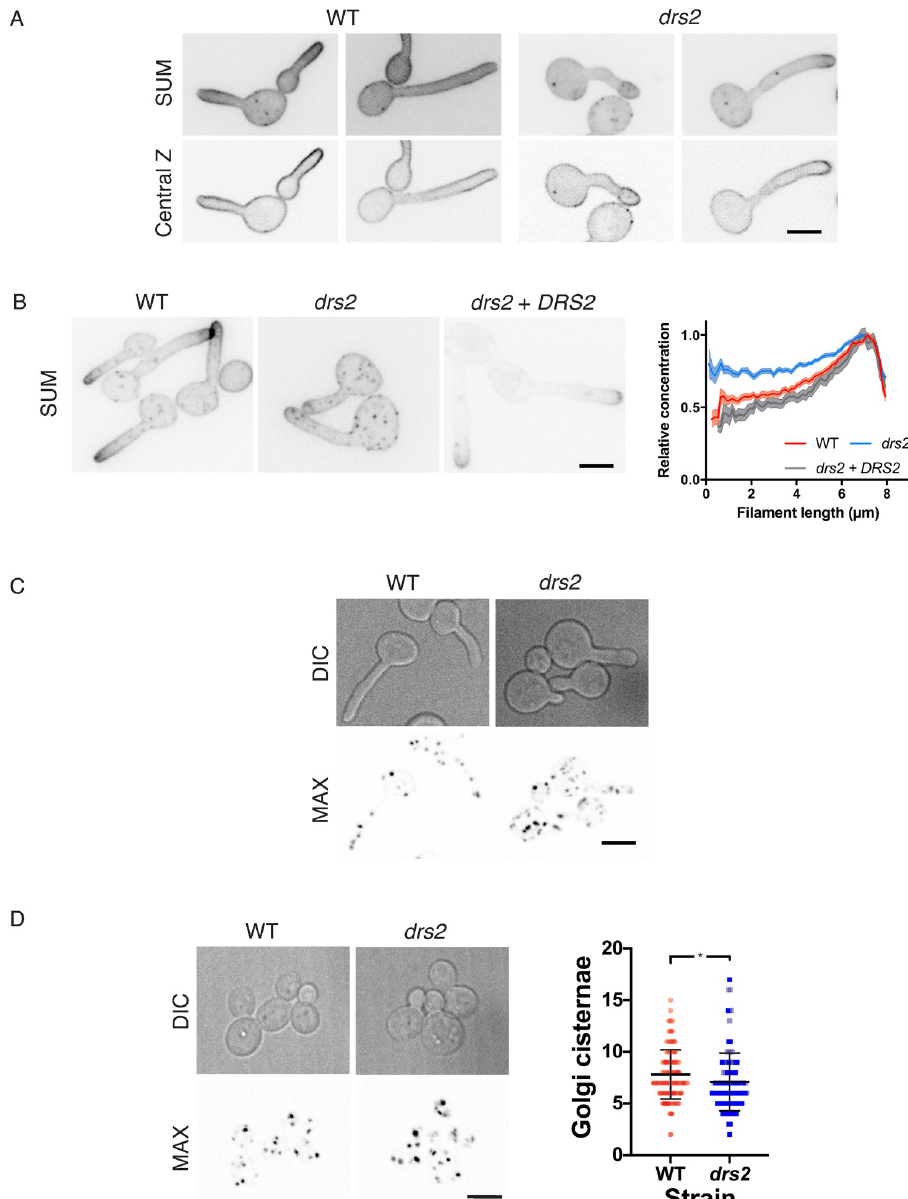
Fig 6. Plasma membrane PI(4)P distribution is altered in the drs2 mutant. A) PM PI(4,5)P 2 distribution is not altered in the drs2 mutant. Wild-type (PY1206) and drs2/drs2 cells ( drs2 , PY4050) expressing GFP-(PH PLC δ 1 ) 2 -GFP were incubated for 60 or 90 min, respectively, in the presence of serum. Sum projections (21 z-sections) and central z- sections of representative cells are shown. B) PM PI(4)P distribution is altered in the drs2 mutant. The indicated cells, WT (PY5619), drs2/drs2 ( drs2 , PY5568) and drs2/drs2 + pDRS2DRS2 ( drs2 + DRS2 , PY6407) expressing GFP-(PH OSH2 [H340R] ) 2 -GFP were incubated for 90 min in the presence of FCS. Sum projections of (21 z-sections) of representative cells are shown. The graph illustrates the means ± the SEM of the relative concentration of PM PI(4)P as a function of filament length, normalized to the maximal signal for each cell ( n = 25–60 cells). C) and D) The number of Golgi cisternae is not substantially affected in the drs2 mutant. DIC and maximum projections (21 deconvolved z-sections) of representative WT (PY2578) and drs2/drs2 cells ( drs2 , PY3873) expressing FAPP1 [E50A,H54A]- GFP incubated in the presence of serum are shown (C). The number of Golgi cisternae per cell was determined in budding cells of the indicated strains from maximum projections of deconvolved images (21 z-sections). (D). Bars indicate the mean ± the SD of 3 independent biological samples ( n = 100 cells and ~700–800 cisternae for each strain). � P < 0.05.